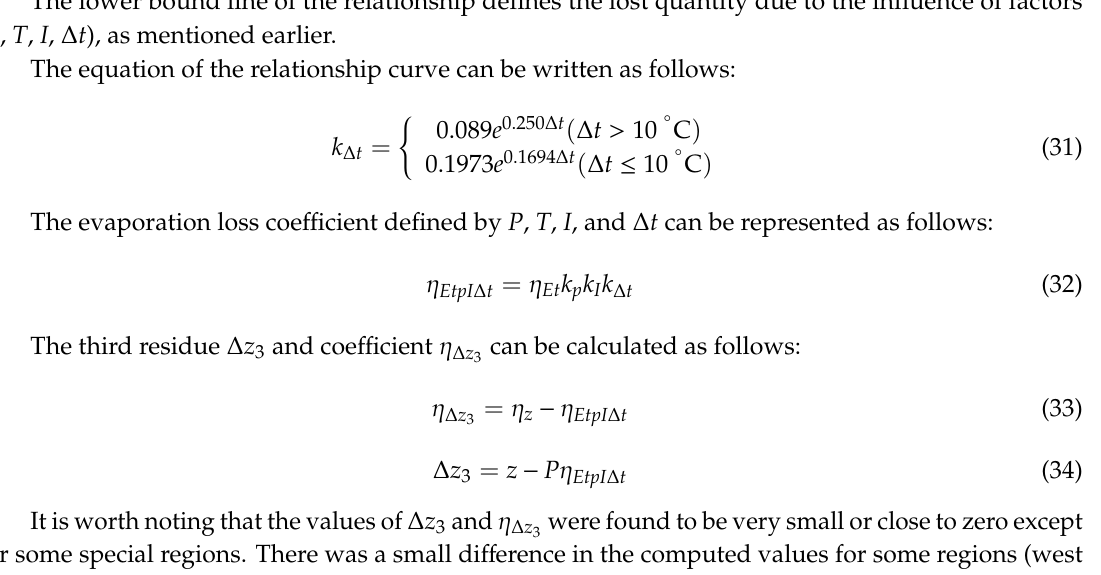
vs. ∆ t and the relationship curve of k ∆ t = f ( ∆ t ) t